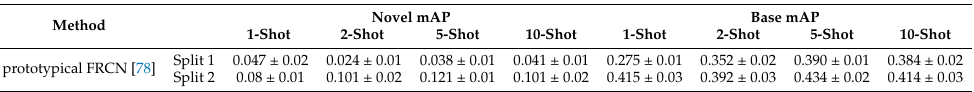
Table 9. FSOD performance (mAP) on the novel classes of the DOTA dataset . The base/novel splitting can be found in Table 1. Prototypical FRCN is a meta-learning-based few-shot